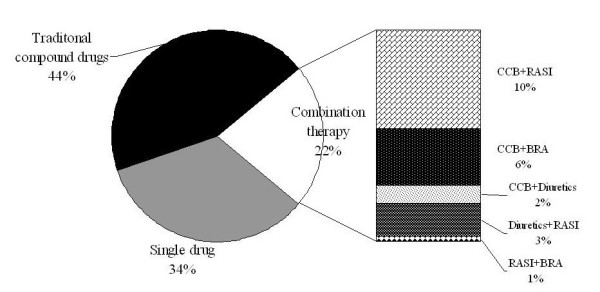
Antihypertensive therapeutic scheme among hypertensive patients undergoing treatment. CCB: calcium channel blockers. RASI: rennin-angiotensin system inhibitors. BRA: beta receptor antagonists.